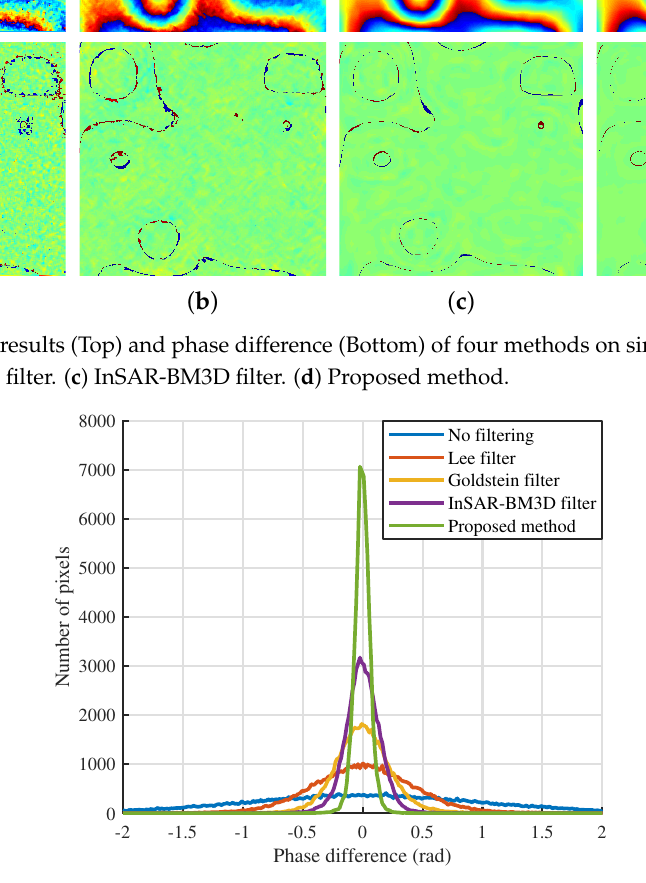
Figure 13. Fitted phase difference histogram curves of four methods. Table 2. Quantitative indexes of four methods on simulated